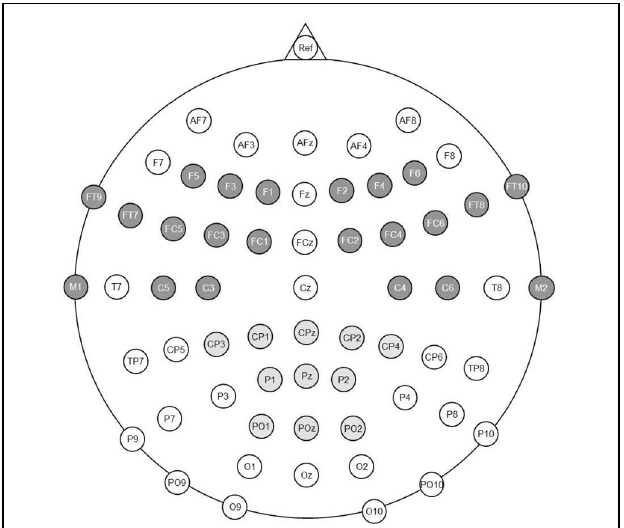
FIGURE 1 | Electrode positions recorded in the experiment. The left and right anterior Regions of Interest are highlighted in dark gray. The central posterior Regions of Interest is highlighted in light